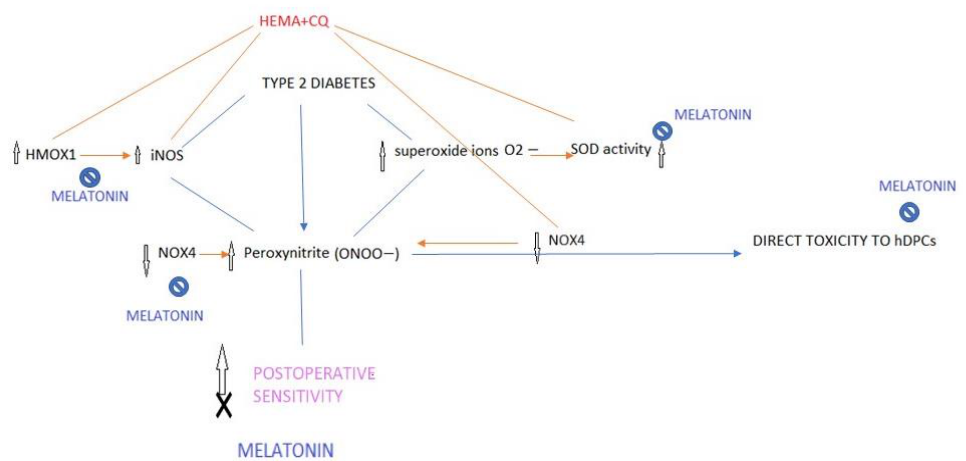
Figure 7. Proposed modus of melatonin interfering with the mechanism of postoperative sensitivity in type 2 diabetes. Diabetes is associated with greater orofacial pain while iNOS plays a key role in peroxynitrite injury of peripheral nerves and nerve pain caused by diabetes (peripheral neuropathy). By decreasing iNOS (HMOX1/iNOS) and superoxide ion generation (SOD activity) as well as by down-regulation of NOX4 in HEMA- and CQ-treated hDPCs, melatonin may attenuate peroxynitrite-mediated nociception and postoperative sensitivity induced by HEMA and CQ.